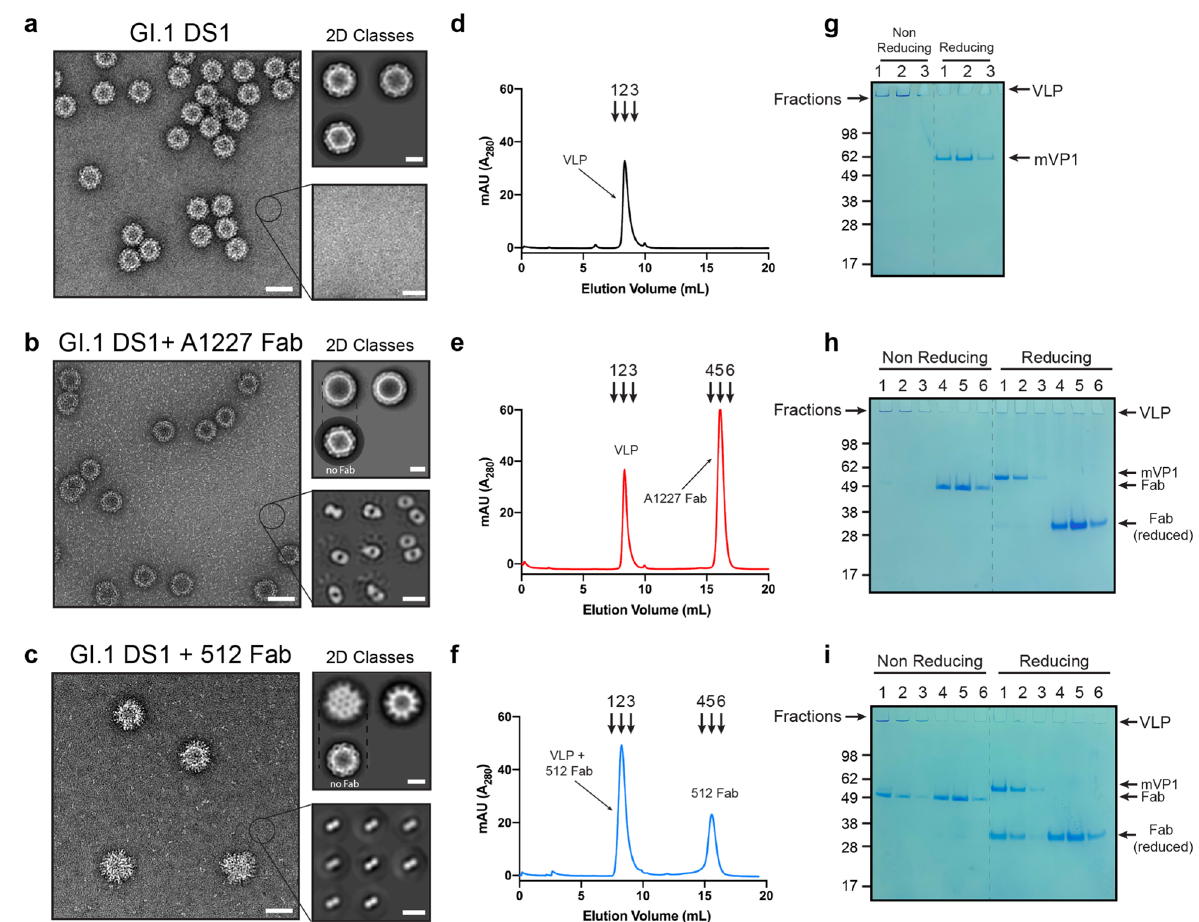
Fig. 4 Stabilization of GI.1 VLPs prevents VLPs from disassembling but preserves accessibility to 512 blockade epitope. a Representative micrograph of stabilized GI.1 VLPs (GI.1 DS1) in the absence of antibody. Particles appear to be intact, and no disassembled components are visible. 2D class averaging yields very homogeneous particle classes with an approximate diameter of 40 nm (top right panel) and no sign of dissociated molecule (bottom right panel). b Representative micrograph of stabilized VLPs after incubation with A1227 Fab. 2D class averages show two species: intact particles with no Fab bound (top right panel) and Fab fragments (bottom right panel). c Representative micrograph of stabilized VLPs after incubation with 512 Fab. 2D class averages show two species: intact particles decorated with 512 Fabs (top right panel) and free Fab fragments (bottom right panel). Notice that the sizes of the intact particles increase by ~7 nm, consistent with the presence of a layer of Fabs bound to each particle. d The sample in a was separated by size-exclusion chromatography and c fractions analyzed by SDS – PAGE in reducing and nonreducing conditions. Only one peak is present at the void volume. Nonreducing gel shows only bands at the top of the wells, consistent with the presence of intact stabilized particles. Notice that no dissociated components are detected. e Size- exclusion pro fi le of stabilized VLPs incubated with 1A227 Fab and f corresponding fractions analyzed by SDS – PAGE. Only two peaks are present: one at the void volume (intact particles) and one corresponding to free Fabs. h Size-exclusion pro fi le of stabilized particles incubated with 512 Fab and i corresponding fractions analyzed by SDS – PAGE. Only two peaks are present: one at the void volume (intact particles with bound 512 Fabs) and one corresponding to free 512 Fabs. In all gels, mVP1 indicates VP1 monomer. Scale bars are 50, 20, and 10 nm for micrographs, 2D classes of VLPs, and 2D classes of small proteins,